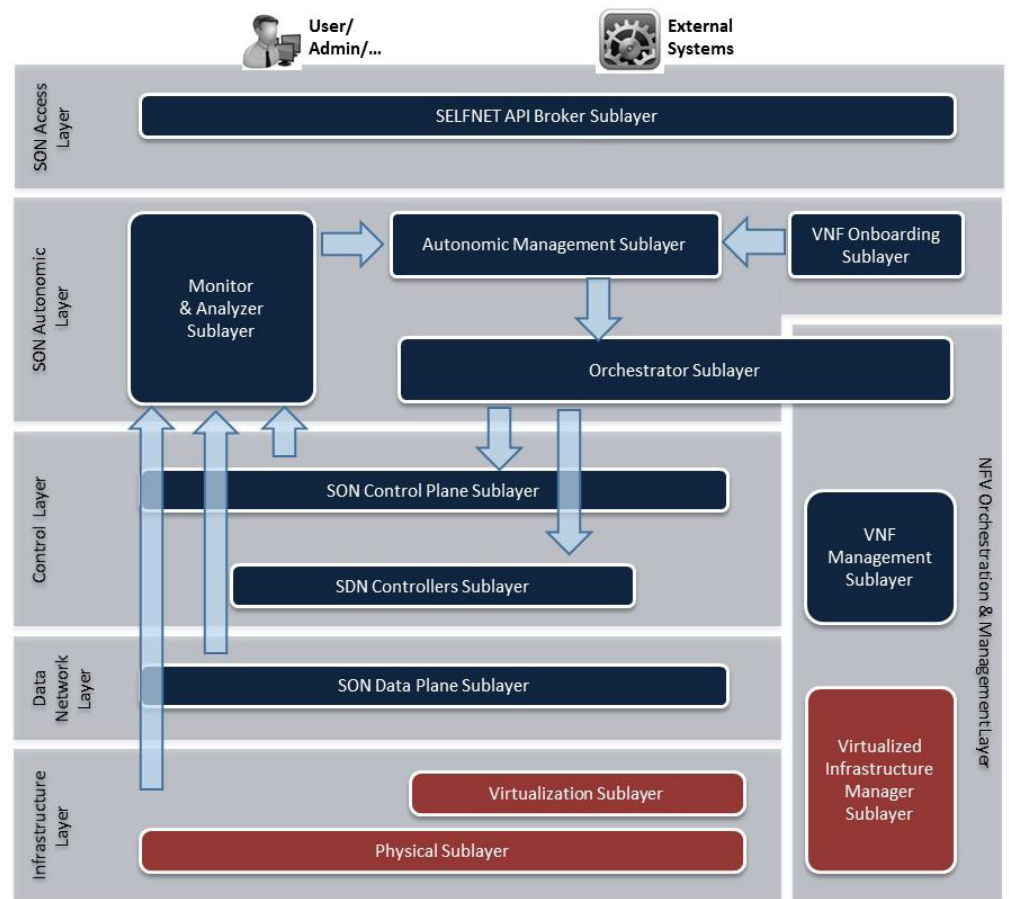
Figure 4. SELFNET Architecture Overview.